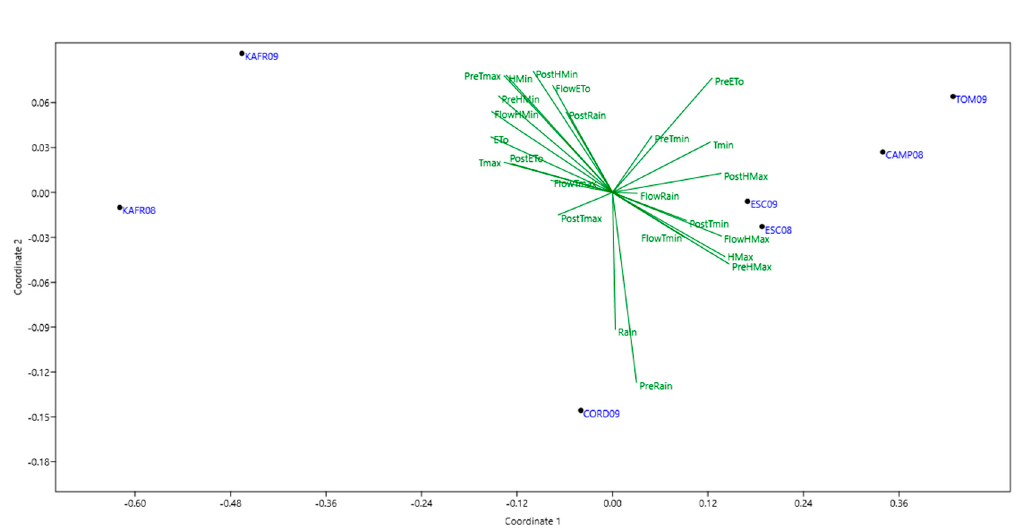
Figure 2. Non metric multidimensional scaling (NMDS) analysis of climate variables including: maximum temperature (Tmax), minimum temperature (Tmin), maximum humidity (Hmax), minimum humidity (Hmin), Evapotranspiration (ETo) and rain during different growing stages [pre-flowering (Pre), flowering (Flow), post-flowering (Post) and complete growing season] characterizing the seven environments, used for phenotyping the number of broomrapes per plant.